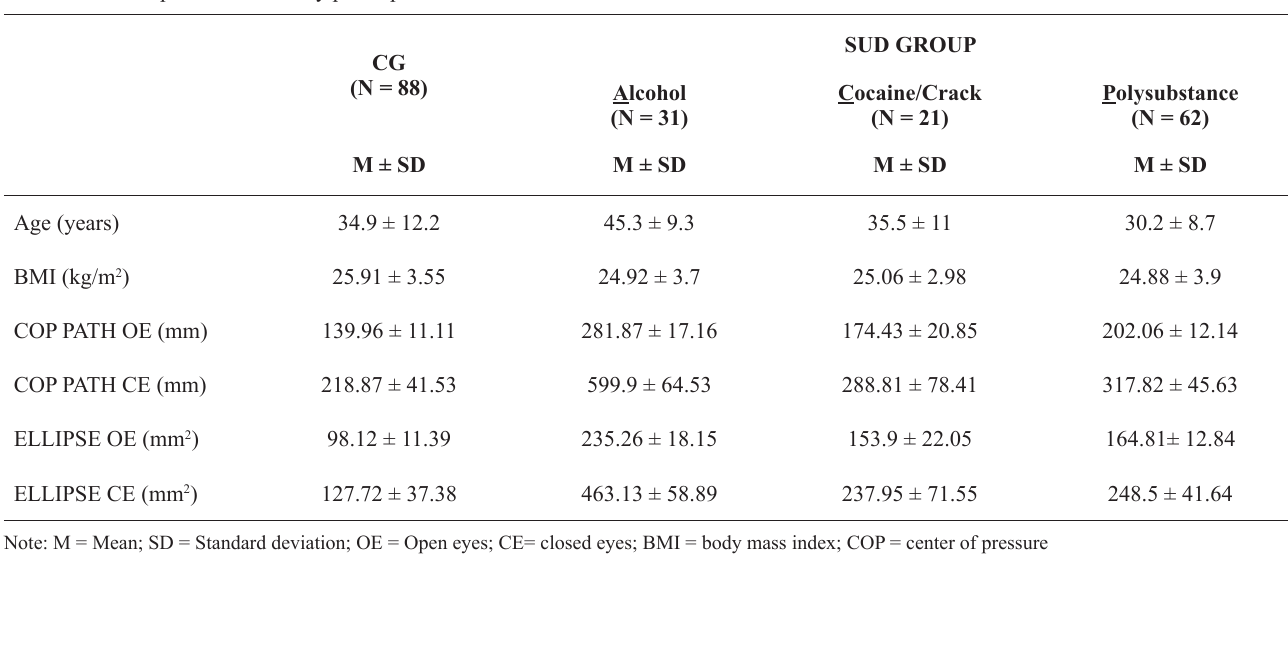
Table 1 . – Descriptive data of study participants.